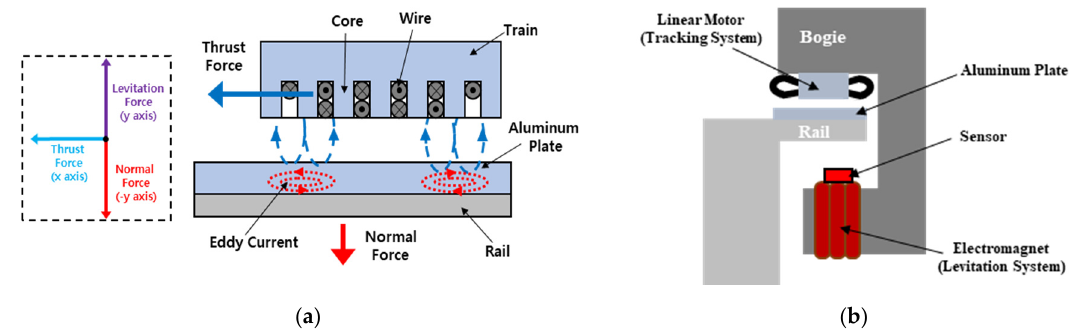
Figure 1. Structure of maglev train: ( a ) Structure of trains and rails and ( b ) Structure of levitation system.